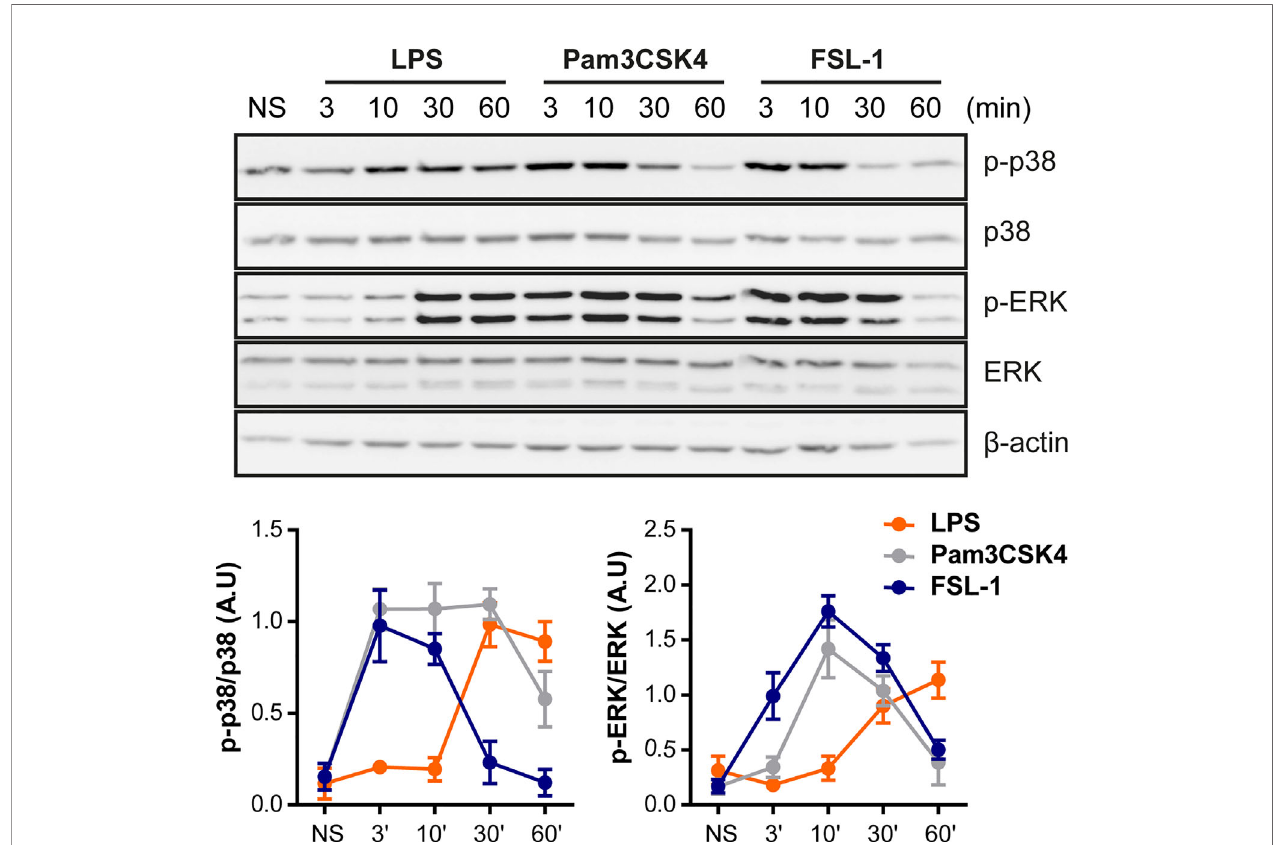
FIGURE 2 | TLR4 and TLR2 ligands exhibit different kinetics on MAPK pathways activation. Raw264.7 cells were treated with LPS (100 ng/mL), Pam3CSK4 (1 µg/ mL) and FSL-1 (100 ng/mL) at 3, 10, 30 and 60 min and stained with the antibodies indicated on the right side of the panels. The graphics below show the quanti fi cation of band intensities of the Western blots. The results are shown as mean ± SEM of three independent